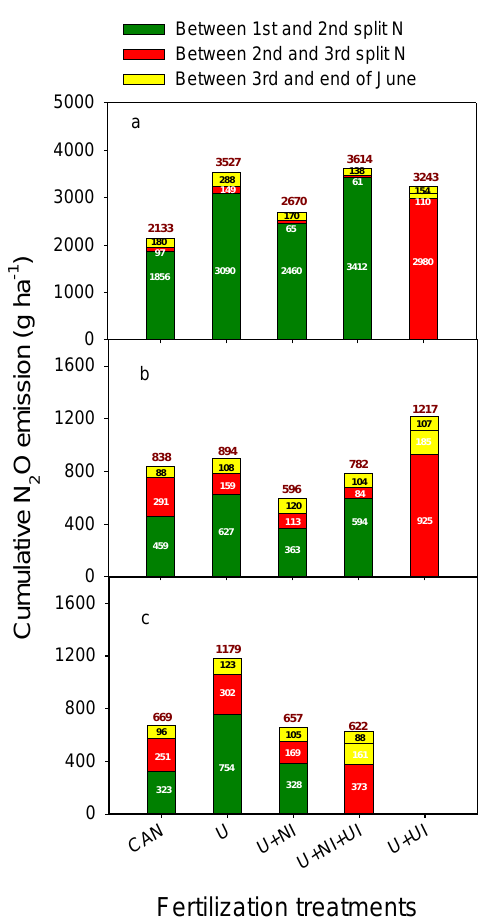
Figure 6. Cumulative N 2 O emission of different fertilization treatments of winter wheat (CAN: calcium ammonium nitrate; U: urea; NI: nitrification inhibitor; and UI: urease inhibitor) with and without an NI in 2004 ( a ), 2005 ( b ), and 2012 ( c ). Kruskal–Wallis-H test indicates no significant difference between fertilization treatments in 2004 ( a ), 2005 ( b ), and 2012 ( c ) at p < 0.05. Table 5. Relative cumulative N 2 O-N losses (% of applied N; Mean ± SD) of different fertilization treatments (CAN: calcium ammonium nitrate; U: urea; NI: nitrification inhibitor; and UI: urease inhibitor) in 2004, 2005, and 2012. Kruskal–Wallis-H test indicates no significant difference between fertilization treatments in 2004, 2005, and 2012 at p < 0.05. Relative Cumulative N 2 O-N Losses (% of Applied Fertilization Treatments